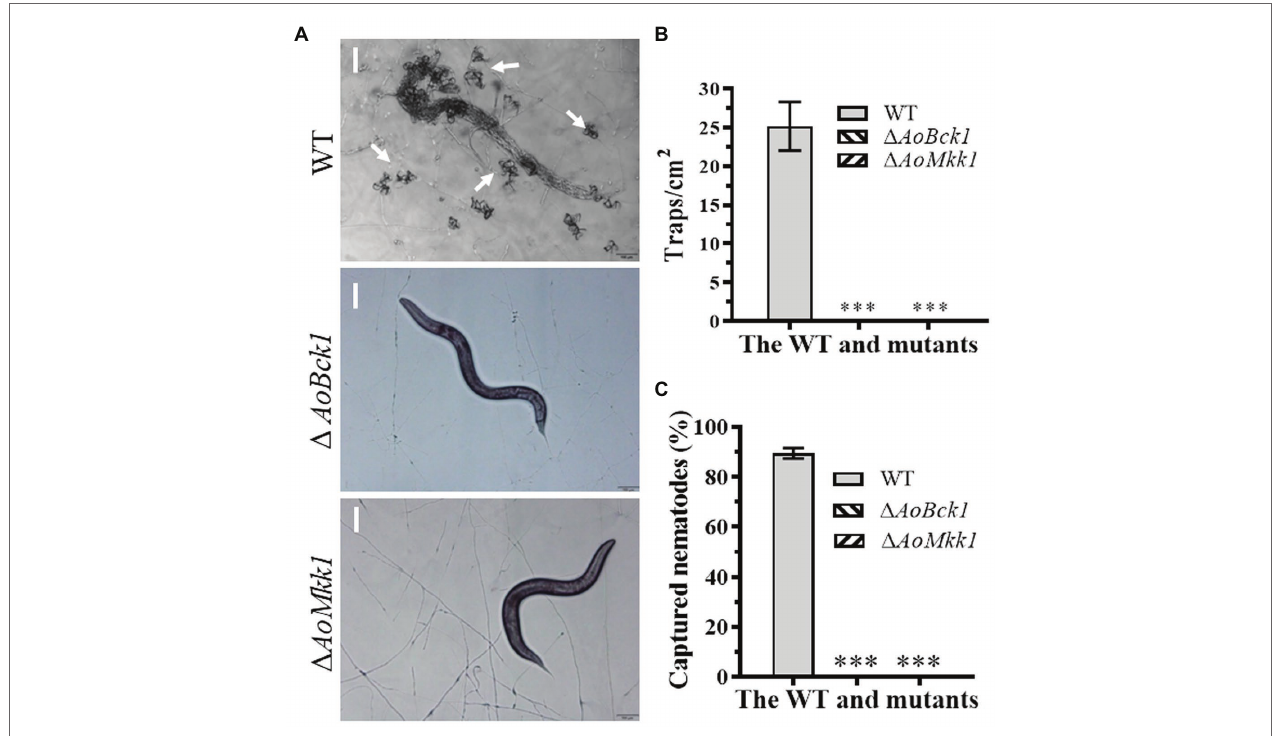
FIGURE 6 | Comparison of trap formation and nematocidal activity between the WT and mutants. (A) Trap formation of fungal strains induced by nematodes at 48 h. White arrows: Traps. Bar: 50 μ m. (B) Comparison of traps produced by the WT and mutants at 48 h. (C) Comparison of captured nematodes by the WT and mutant strains at 48 h. The asterisk indicates a significant difference compared to the WT ( p <